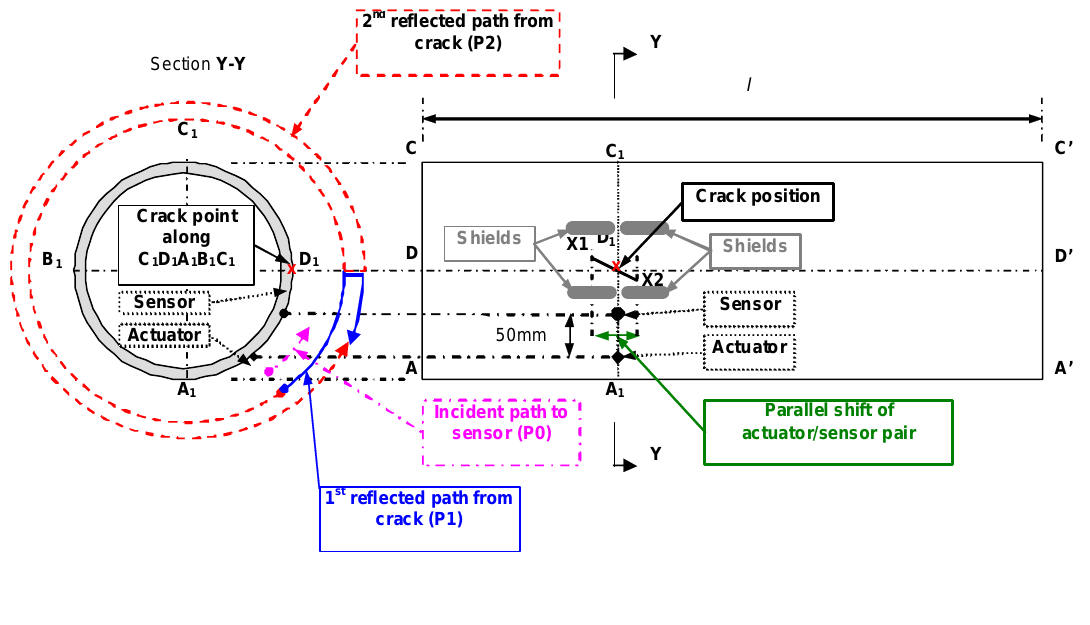
Figure 10. Schematic view of experimental set-up for directed wave propagation in aluminum plate via IDT (adopted from Figure 14 in